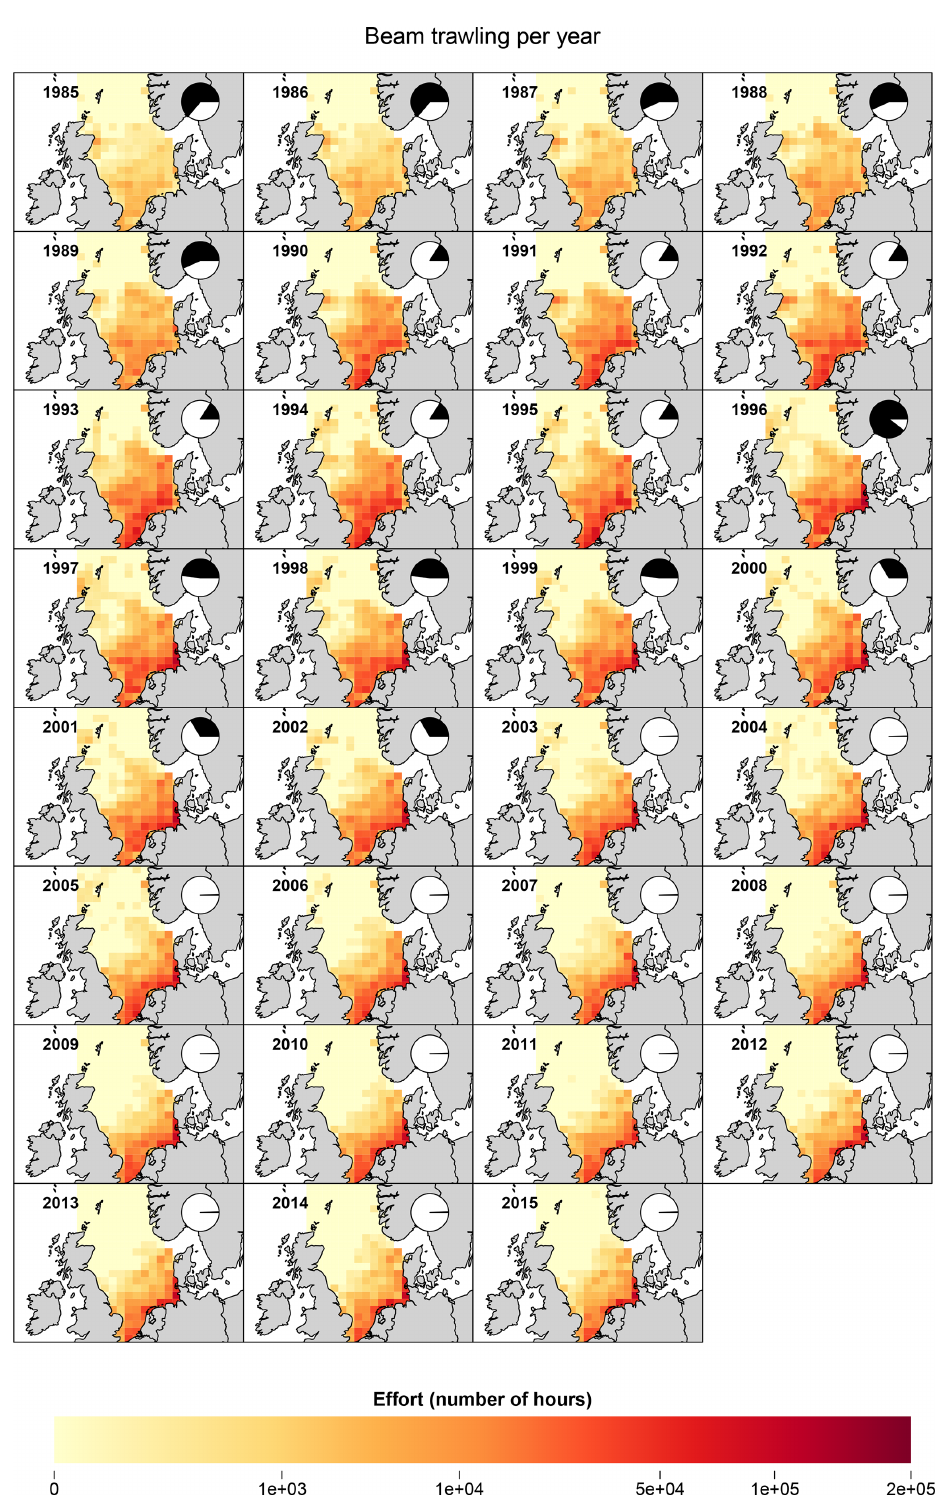
Figure 3. Spatial distribution of beam trawling effort (number of hours trawling per ICES rectangle) in the North Sea in 1985–2015. Pie charts in the top right corners of each plot show the proportions of reconstructed trawling effort sourced from compiled (nominal) data (white) and estimated data